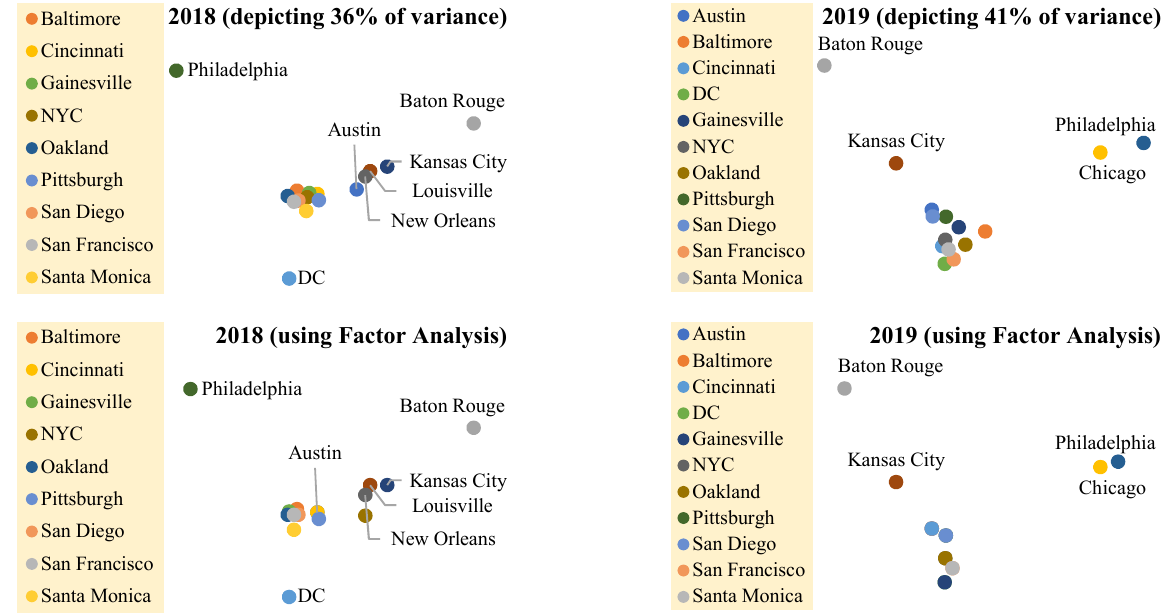
Figure 2. Visual clustering of cities based on non-emergency SR type rates in different years. PCA takes advantage of all the original features and linearly combines them to best preserve the distance between the samples after projection to the two-dimensional